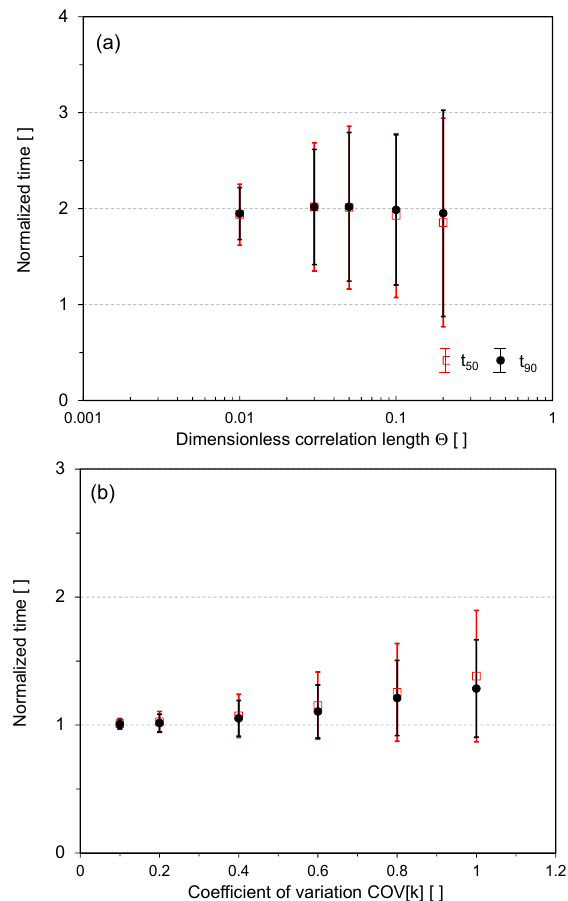
Figure 8. Effect of dimensionless correlation length in spatially varying hydraulic conductivity k on consolidation times t 50 and t 90 of heterogeneous soils with different drainage conditions; ( a ) No vertical drainage; ( b ) Vertical drainage.